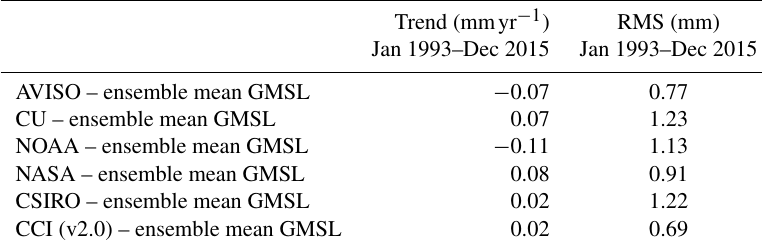
Table 1. Trend and root mean square of the difference between individual GMSL time series and ensemble mean GMSL (mean of observed GMSL). Note that all GMSL records are not corrected for the TOPEX-A instrumental drift (see text).